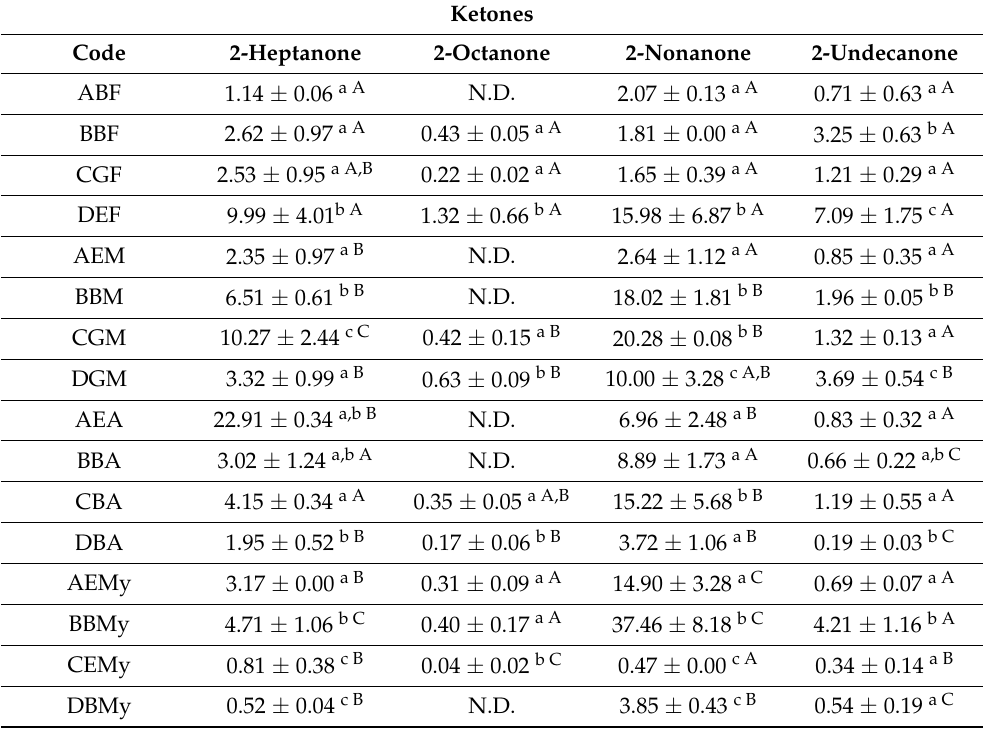
Table 7. Volatile ketones (mean ± standard deviation; mg/100 g) in samples from producers A, B, C and D, during four consecutive months of